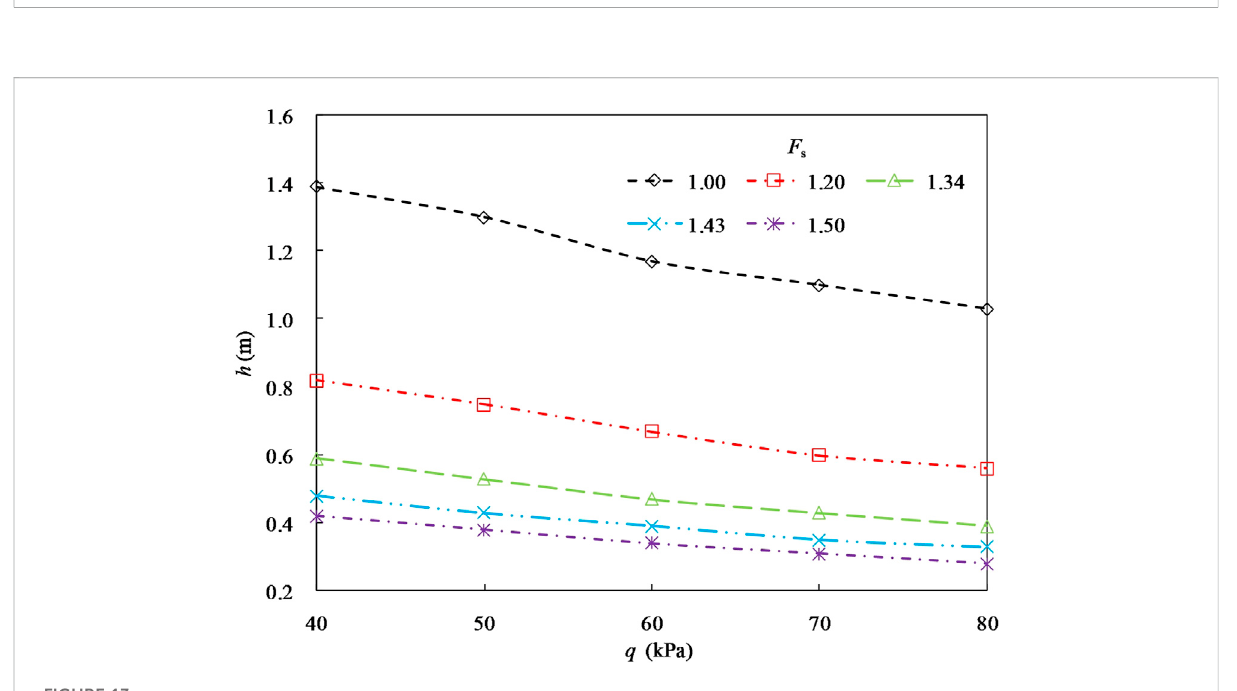
FIGURE 13 Relationship between h and q under different F s